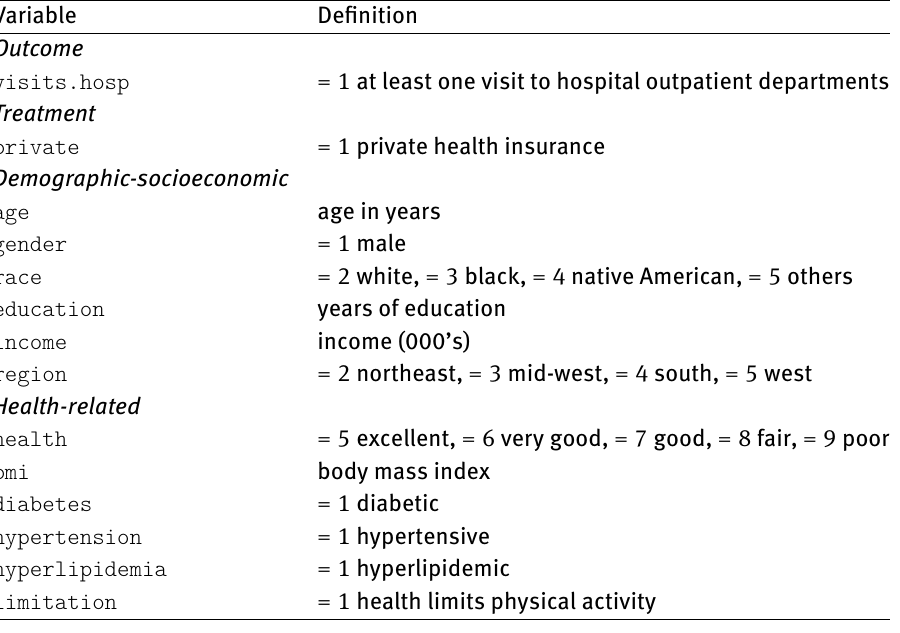
Table 1: MEPS data: description of the outcome and treatment variables, and observed confounders. Variable